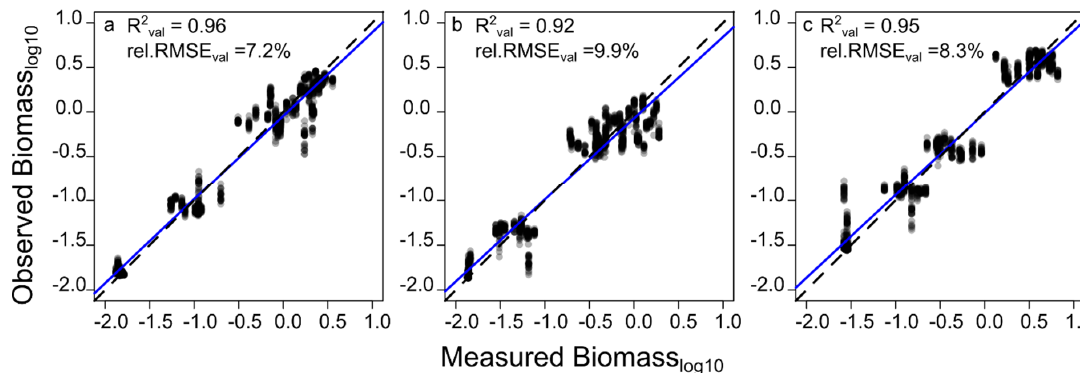
Figure 5. Predicted versus observed biomass based on the best machine learning method (i.e., random forest regression) for 100 validation datasets based on the best performing explanatory set of variables for ( a ) eggplant, predicted using the spectral variables, ( b ) tomato, predicted using the height parameters, and ( c ) cabbage, predicted using the height variables. The prediction quality measures (i.e., R 2 and rel . RMSE val ) are averaged over all 100 model runs. The blue line indicates the linear relationship of the values while the dotted line shows the 1:1 (perfect fit) line.